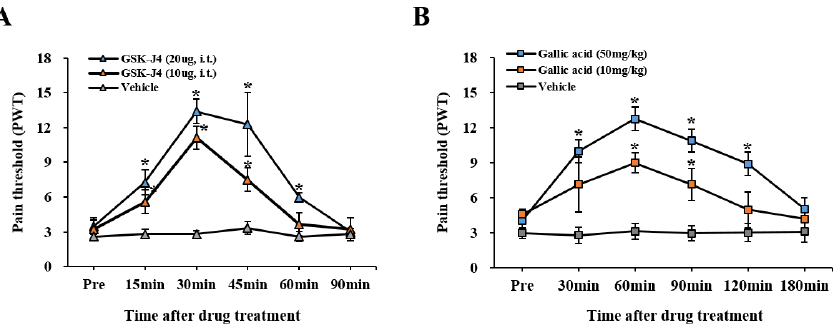
Figure 7. Blocking Jmjd3 activity alleviated LSS-induced mechanical allodynia. Thirty days after compression, rats underwent a pre-pain test (Pre) and were then injected with GSK- J4 (10 or 20 μg, i.t.) or Gallic acid (10, 50 mg/kg, i.p.). ( A , B ) Mechanical allodynia by von Frey filaments (n = 8). Data are presented as the mean ± SEM. * p < 0.05 vs. vehicle.